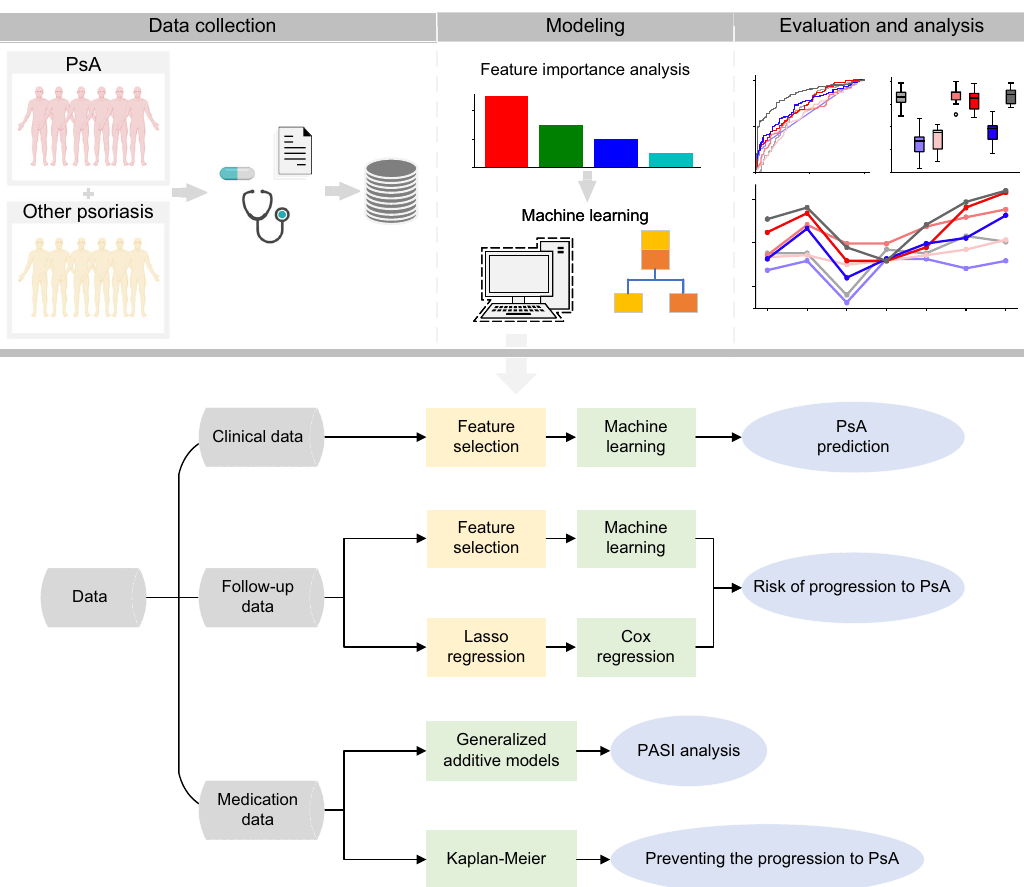
Fig. 2 A graphical illustration of this study. The patients ’ clinical data collected from Xiangya Hospital were utilized for three different tasks: PsA diagnosis, PsA progression prediction, and drug ef fi cacy analysis of psoriasis